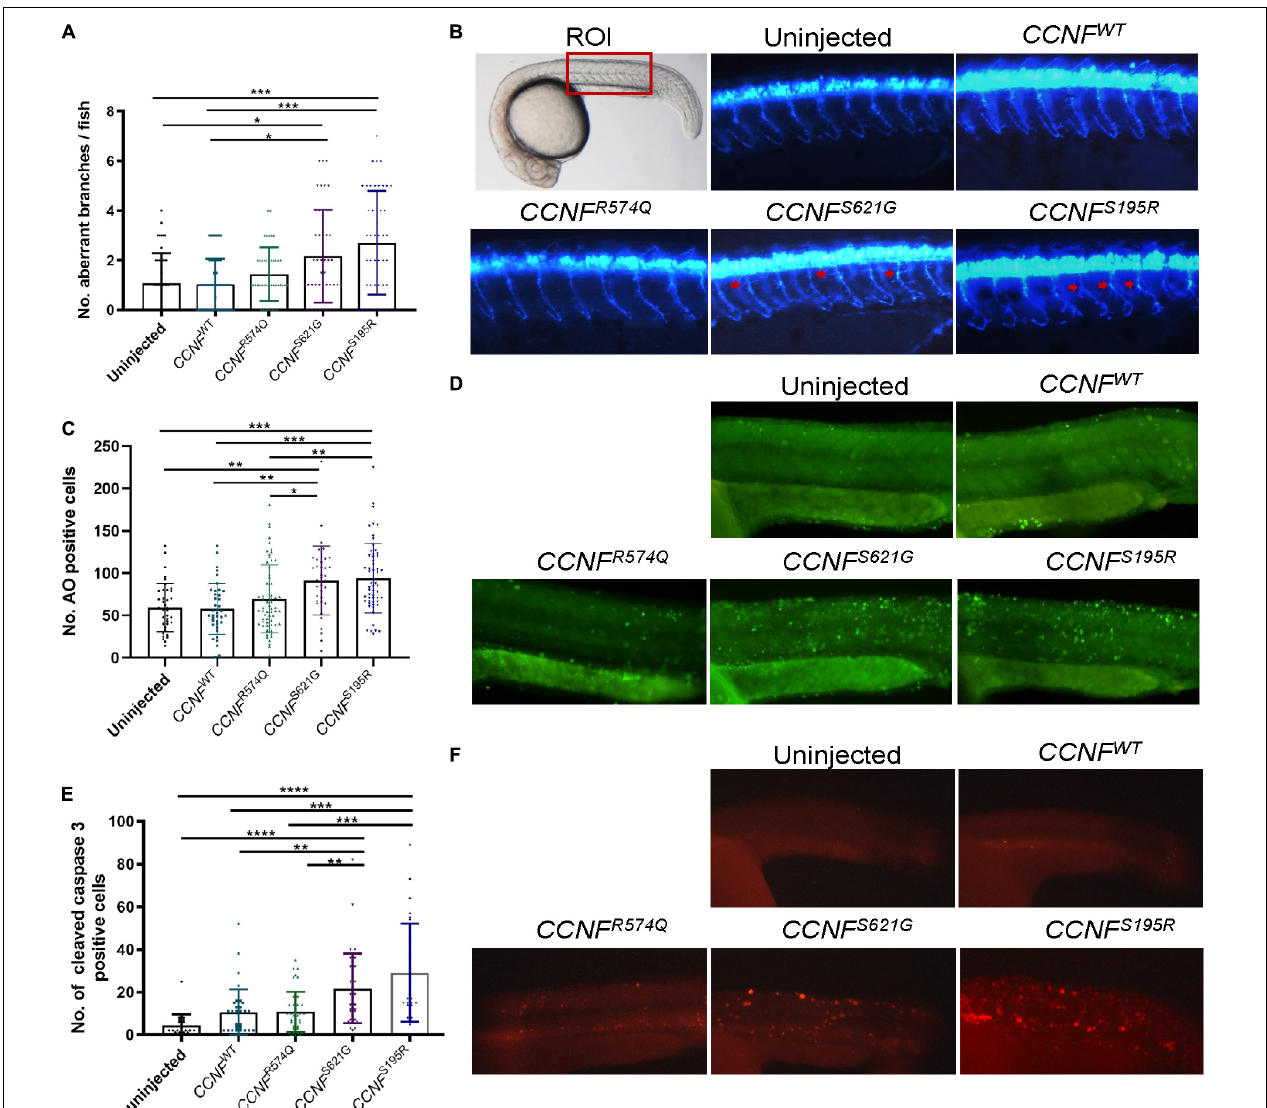
FIGURE 7 | Measurements of aberrant neuron branching and apoptosis activation in zebrafish injected with CCNF gene variants S621G, S195R, R574Q, and wild type. (A) Blinded analysis of the number of aberrant branches in zebrafish expressing cyclin F S621G and S195R, respectively, had 2.01-fold ( p -value = 0.006, n = 42) and 2.4-fold ( p -value = 0.0011, n = 46) more aberrantly branched motor neurons compared to the wild type (one-way ANOVA). Region of interest (ROI) in zebrafish used for imaging. (B) Representative images of zebrafish expressing blue fluorescent protein in motor neurons used to analyse primary motor axon branching. Examples of aberrant branching indicated by red arrows. (C) Cyclin F S621G and S195R had displayed increased cleaved caspase-3 activity by 2.08-fold ( n = 39, p -value = 0.0029 and 2.79-fold ( n = 28, p -value = 0.0004) (one-way ANOVA adjusted with Kruskal–Wallis test). ( D ) Representative images of live zebrafish staining with AO. (E) AO positive cells in S621G and S195R were 1.4-fold ( p -value = 0.0496, n = 37) and 1.45-fold ( p -value = 0.0115, n = 57) higher, respectively, compared to the wild type (one-way ANOVA). ( F ) Representative images of zebrafish immunostained with cleaved caspase-3 primary antibody. * p ≤ 0.05, ** p ≤ 0.01, *** p ≤ 0.001, **** p ≤